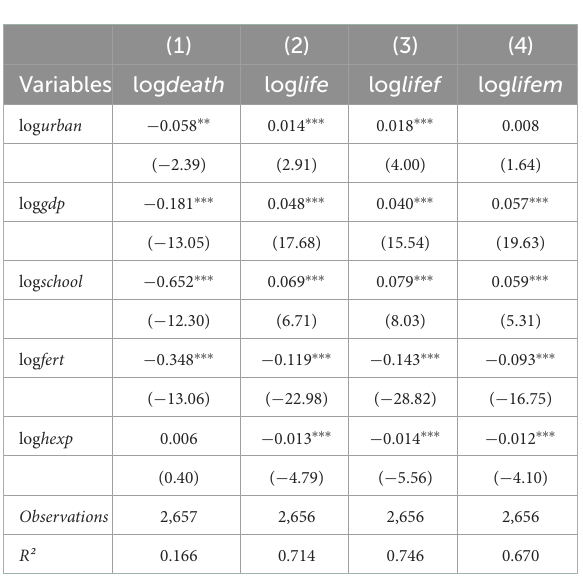
TABLE 3 OLS estimation results.